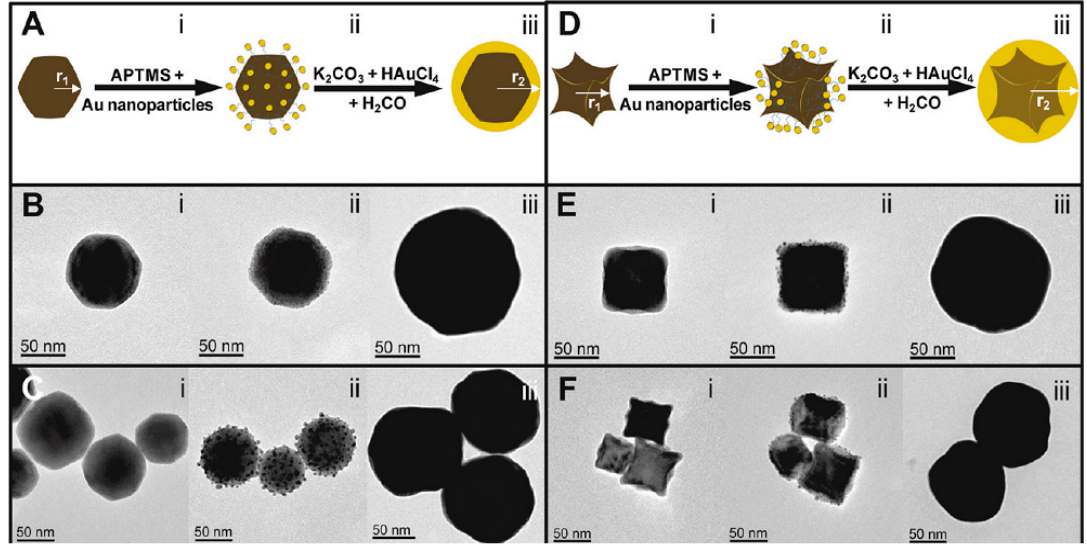
Figure 5. Schematic overview of the gold coating of ( A – C ) faceted and ( D – F ) tetracubic iron oxide cores. Representative TEM images of (i) the starting iron oxide cores; (ii) the decorated ones by Au precursors; and (iii) the coated ones by a continuous Au shell are given for illustration. Reproduced with permission from [50] . American Chemical Society, 2009.